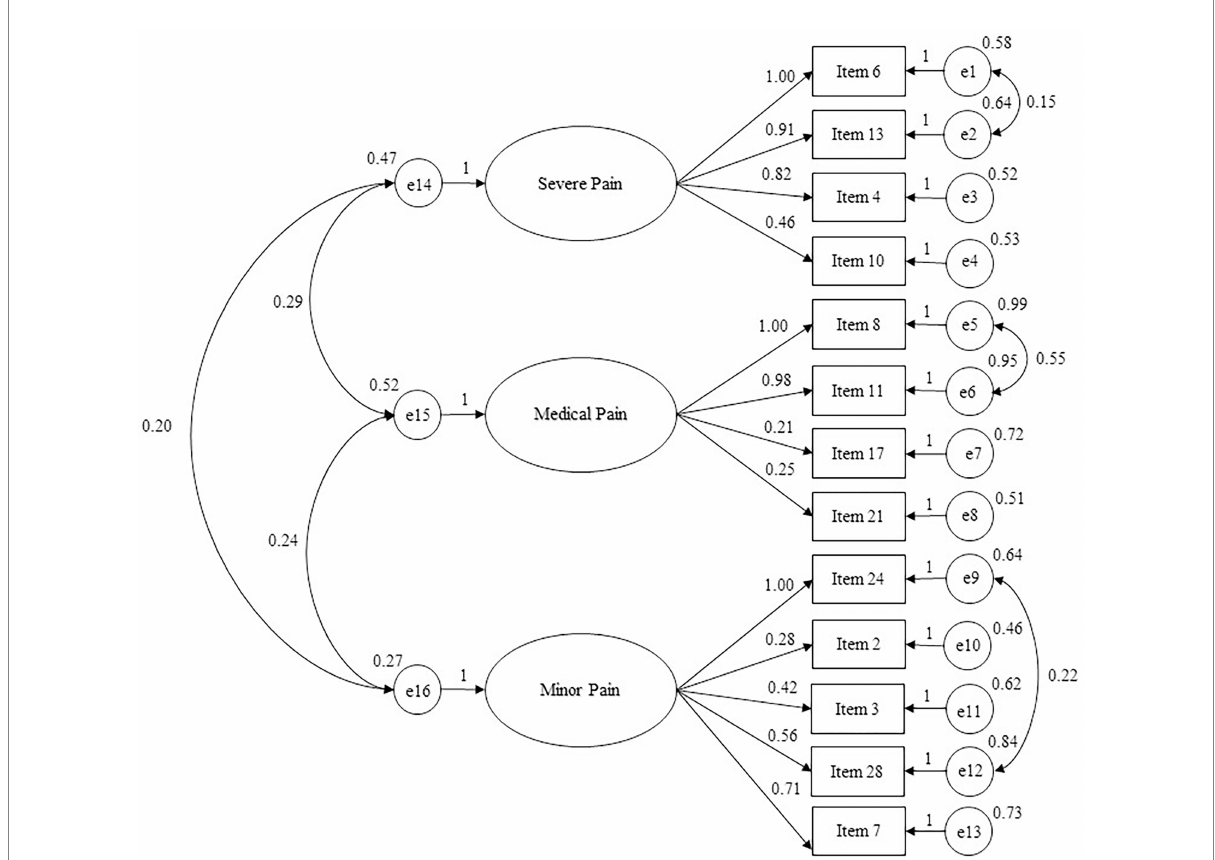
FIGURE 2 Path diagram of the confirmatory analysis concerning FPQ-III short form (13 items). χ 2 /df = 2.51; RMSEA = 0.046; RMSEA 90% CI = 0.037–0.056; GFI = 0.969; TLI = 0.962; CFI = 0.971; NFI = 0.953.